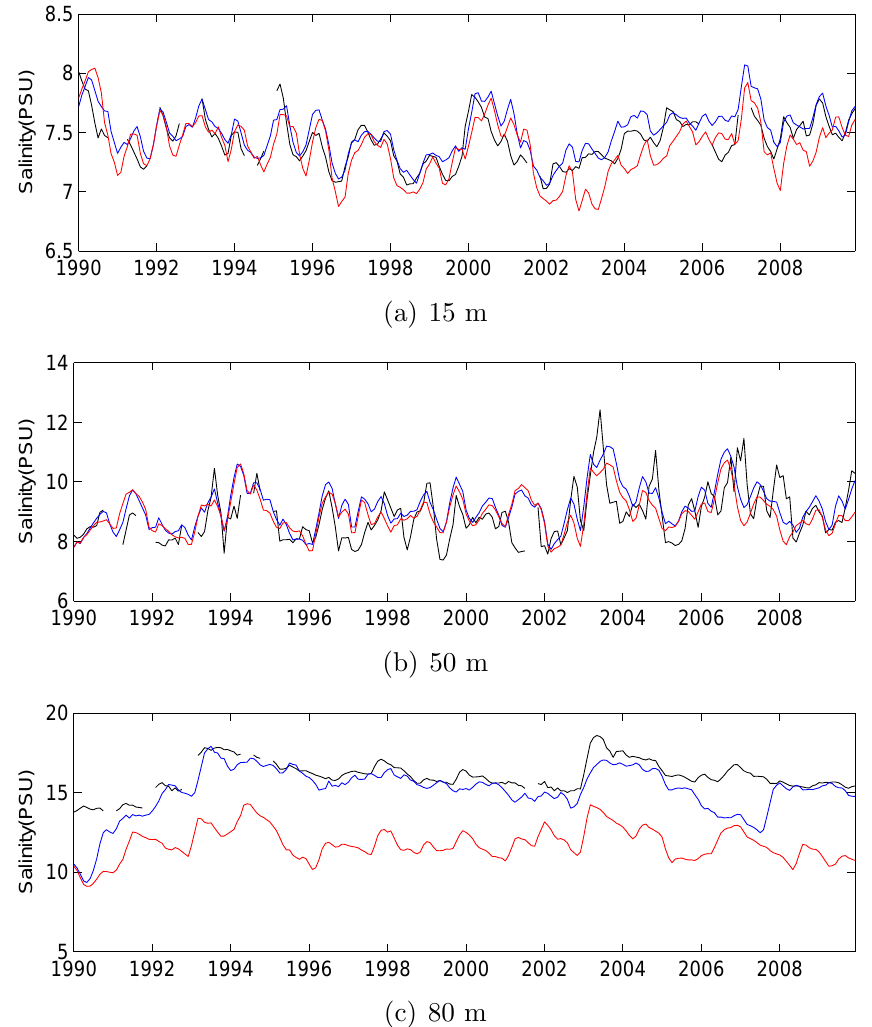
Fig. 7. The time series of salinity at 55.15 ◦ N, 15.92 ◦ E for the depth of (a) 15m, (b) 50m, and (c) 80m. The red is the free run, the blue is Figure 7: The time series of salinity at (55.15 ◦ N, 15.92 ◦ E) for the depth of the reanalysis and the black is for (a) 15 m, (b) 50m and (c) 80 m. The red is the free run, the blue is the reanalysis and the black is for observations.